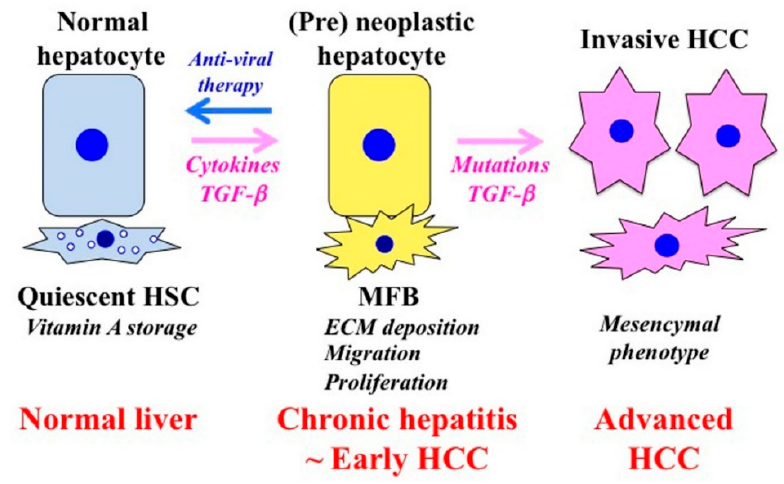
Figure 2. Phenotypic alternations of hepatocytes and HSC during the fibrocarcinogenic process in human chronic liver diseases. Quiescent hepatic stellate cells (HSC) are characterized by retinoid droplets in the cytoplasm and maintain liver homeostasis. HSC undergo constitutive activation to become myofibroblasts (MFB)-like cells after liver injury. MFB persistently produce an extracellular matrix (ECM) and induce liver fibrosis. The contraction of MFB contributes to increased portal resistance during liver fibrosis that presumably is reversible until the thickened septae, intrahepatic shunts, and lobular distortion that are characteristic of cirrhosis development, leading to fixed increases in portal pressure. Chronic liver damage promotes recurrent cycles of cellular proliferation, inflammation, fibrosis, and carcinogenesis. In pre-neoplastic hepatocytes, several growth factors and cytokines activate proliferation and invasion. As human hepatitis virus-related chronic liver diseases progress, chronic inflammation and hepatitis virus additively accelerate liver fibrosis and increase the risk of hepatocellular carcinoma (HCC). Genetic and epigenetic changes in the liver result in carcinogenesis. Effective antiviral therapy can reverse the pre-neoplastic properties of hepatocytes to a tumor-suppressive mode before the occurrence of genetic mutations that have been implicated for HCC occurrence.